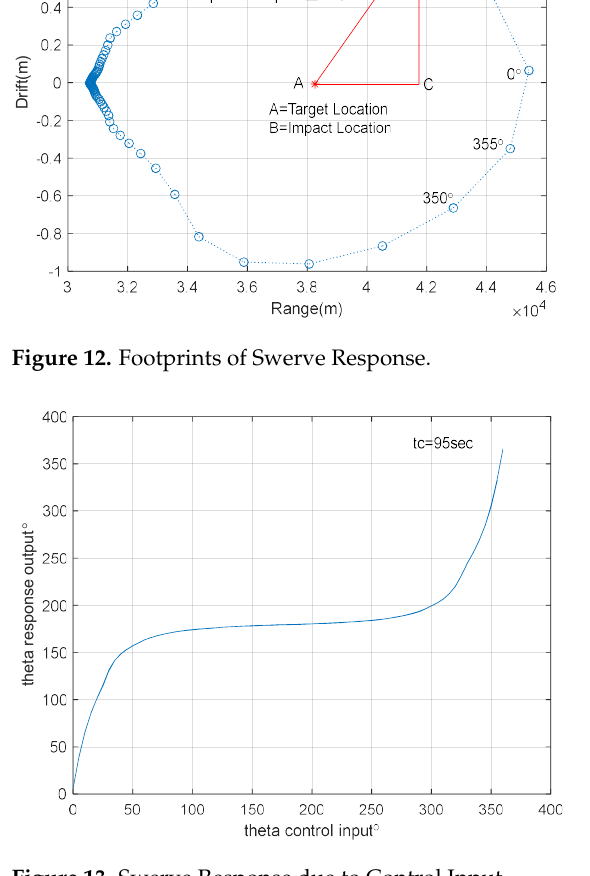
Figure 13. Swerve Response due to Control Input.